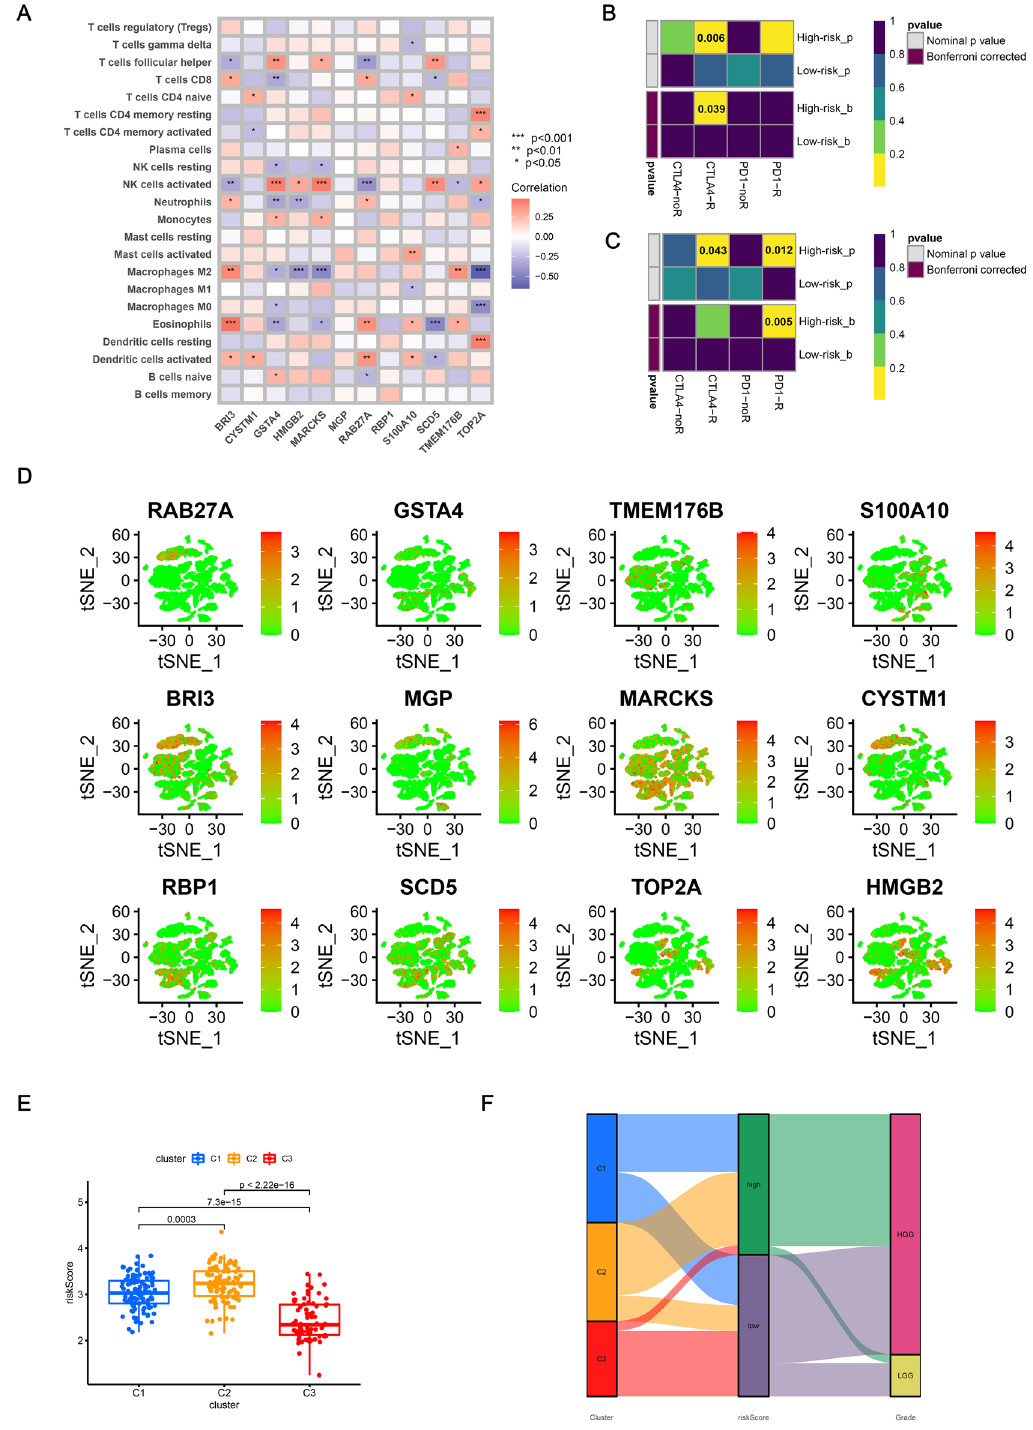
Figure 7. ( A ) Heatmap showing the correlation between the expression levels of 12 prognostic genes in our model and the abundance of infiltrating immune cells. ( B ) Unsupervised subclass mapping analysis of the response to immunotherapy between high-risk group and low-risk group in the training cohort. ( C ) Verification of the above results using the validation cohort. ( D ) The expression patterns of the 12 prognostic genes in the subgroups of the single-cell RNA-seq data. ( E ) Comparison of the risk scores across the three clusters. ( F ) Alluvial diagram showing the distribution of three clusters in different risk groups and